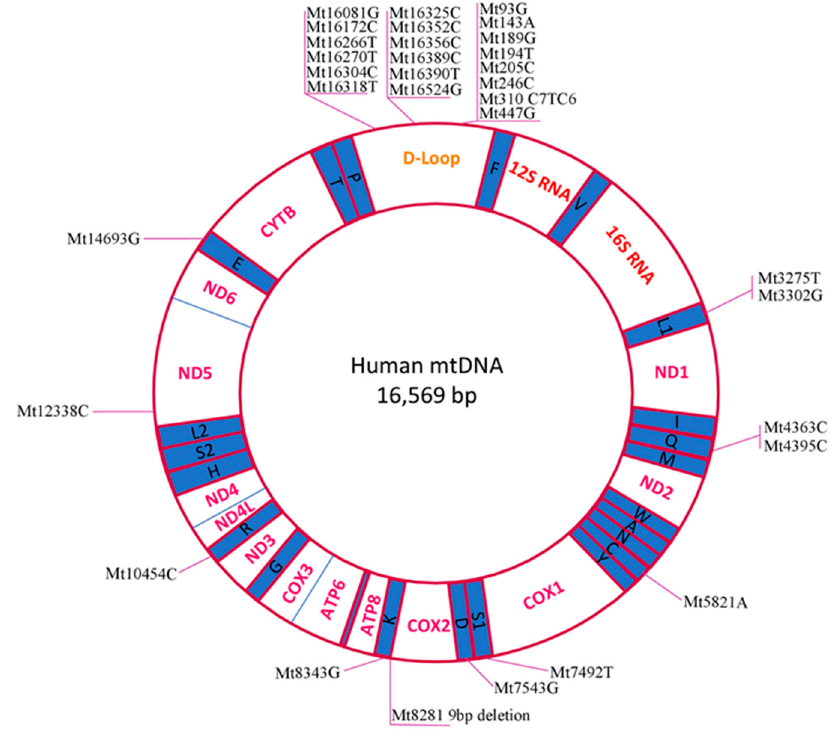
Figure 1. Simplified map of the human mitochondrial genome. The mtDNA mutations associated with PCOS, listed in Table 1, are marked.